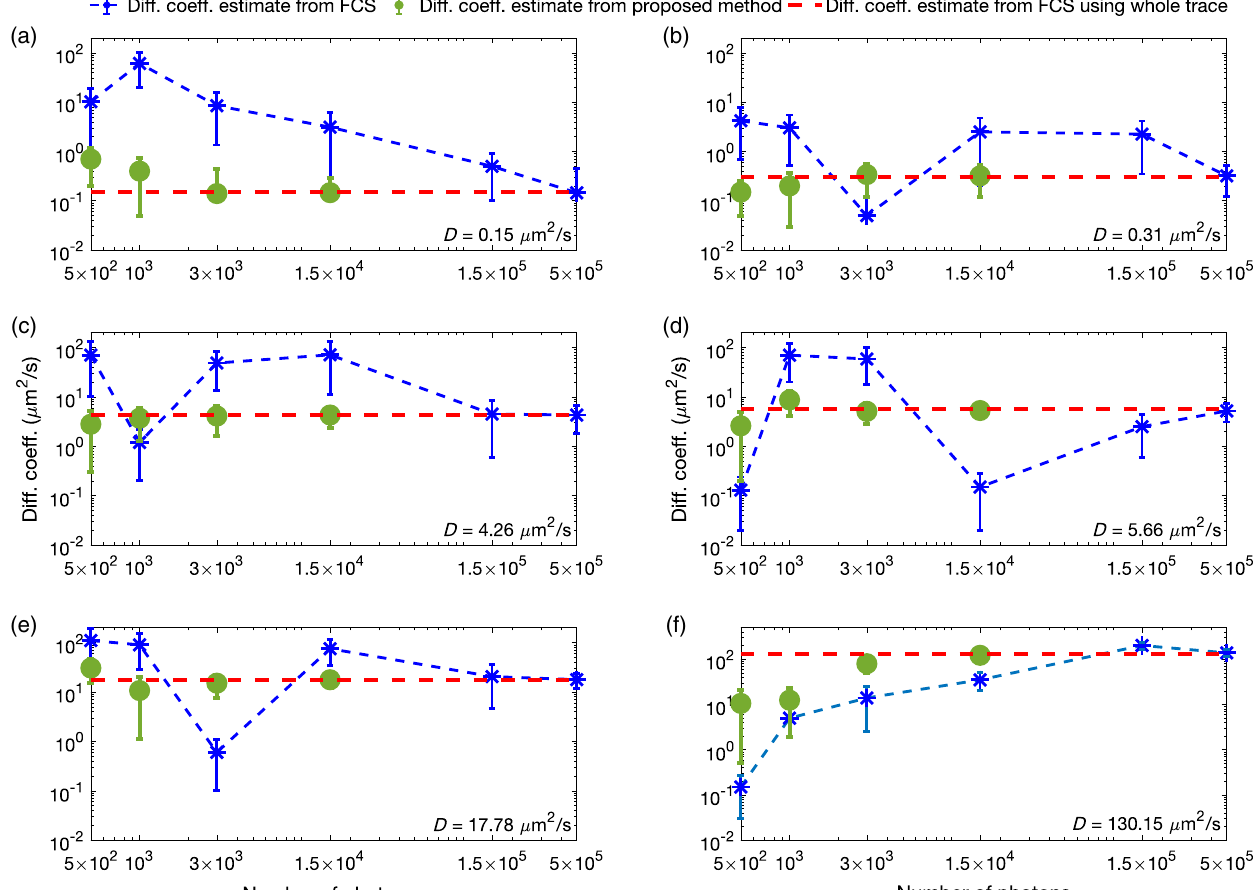
FIG. 9. Lower diffusion coefficients in experimental traces provide more photons per unit time and sharper diffusion-coefficient estimates. Estimates shown are drawn from experimental traces with 99% glycerol (a), 94% glycerol (b), 75% glycerol (c), 67% glycerol (d), 50% glycerol (e), and 0% glycerol (f) with fixed concentration 1 nM of Cy3 dye molecules and laser power of 100 μ W. Similarly to Fig. 1, we compare our method ’ s diffusion-coefficient estimate (circle green dots) to FCS (blue asterisk) as a function of the number of photons used in the analysis. Since by 1 . 5 × 10 4 photon arrivals our method has converged, we avoid analyzing larger traces. The red dashed line is the FCS estimate produced from the entire 5-min trace containing ≈ 3 × 10 6 photon